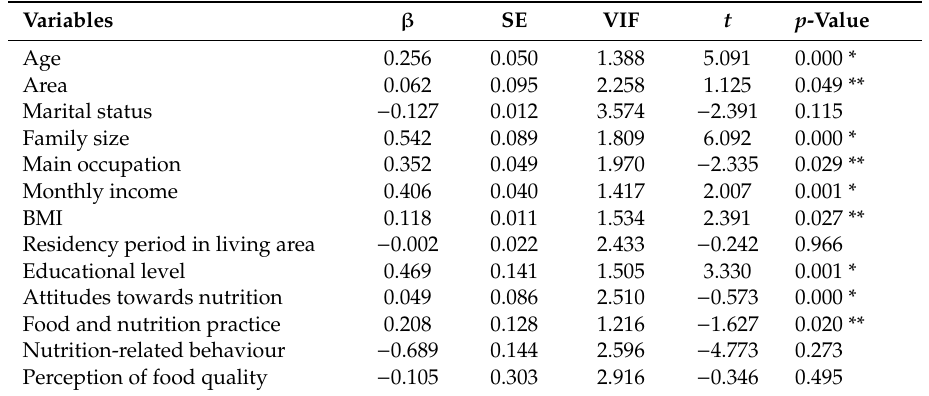
Table 7. Multiple linear regressions to identify factors that a ff ect food and nutritional knowledge of reproductive-age women in rural and urban areas of Sri Lanka ( N = 400).